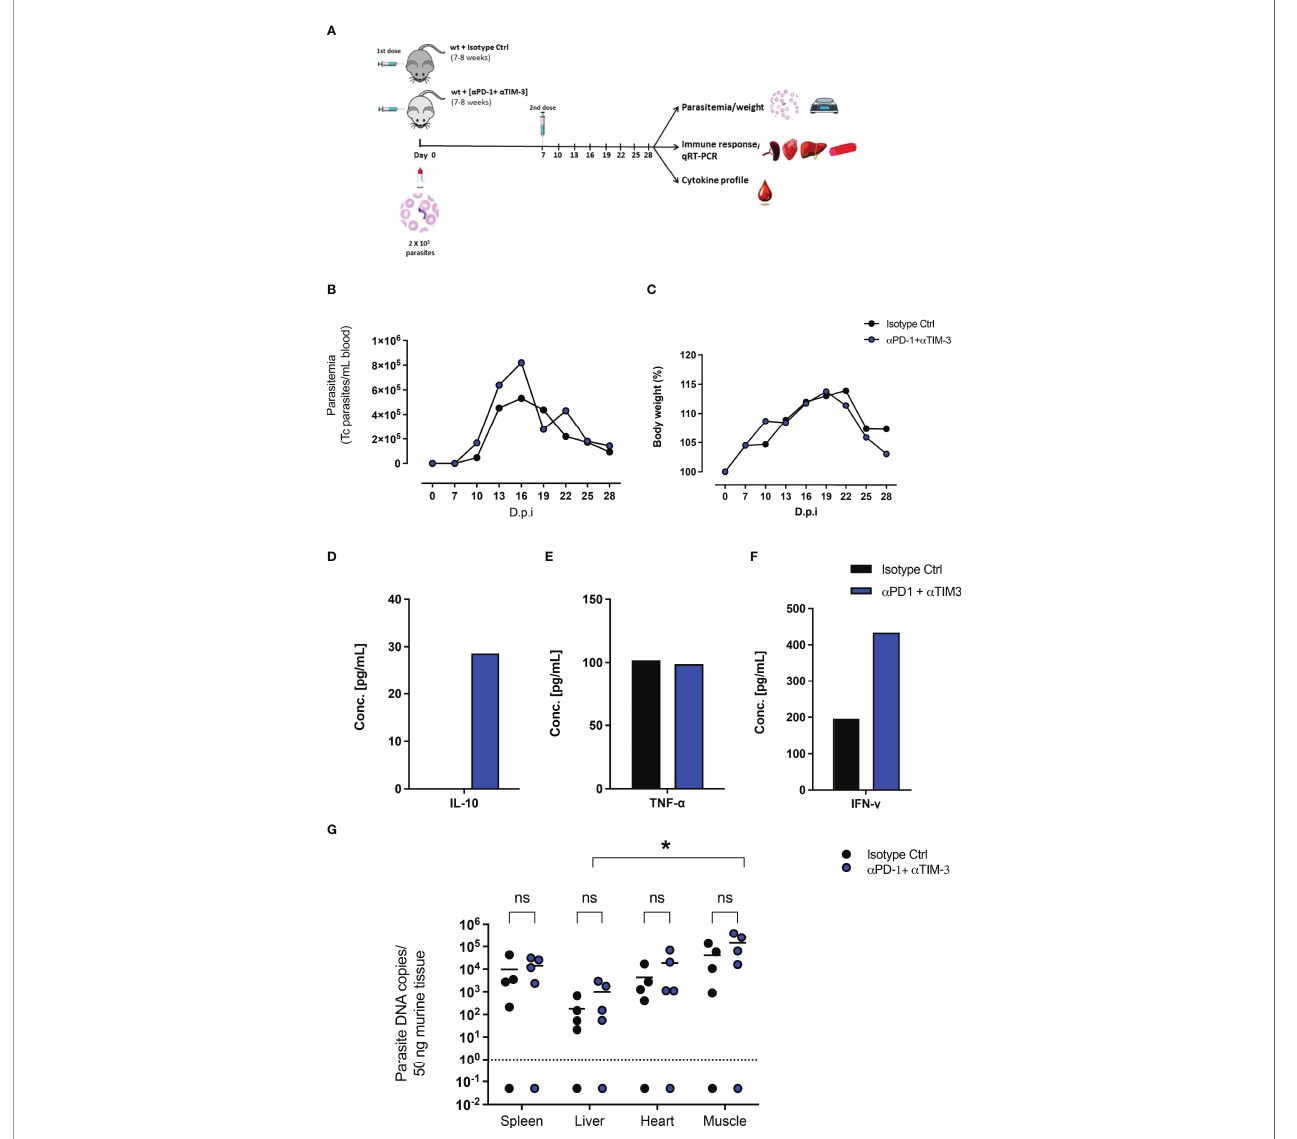
FIGURE 4 | Combined therapeutic intervention with a PD-1 and a Tim-3 monoclonal antibodies does not reduce parasitemia but induces IL-10. (A) Scheme of infection and combined a PD-1 and a Tim-3 therapy. Mice were infected i.p. with 2x10 3 T. cruzi parasites on day 0. They received a PD-1 and a Tim-3 in a concentration of 0.2 mg each/dose on day 0 and day 7 after infection. The control group received i.p. 2 doses of isotype antibody in the same concentration. WT mice infected and isotype treated n=8; WT infected and a PD-1+ a TIM- 3 n=7. Results from two independent experiments (B) Parasitemia and (C) body weight were analyzed over the course of infection (28 days) and are shown as means with SD. Whole blood samples were collected, and sera were isolated and pooled. Cytokine levels were determined by a cytometric bead assay. Results are expressed as the cytokine concentration of the pooled sera samples (D) IL-10, (E) TNF- a , and (F) IFN- g . (G) Effect of interruption of PD-1/PD-L1 signaling on parasite load analyzed by T. cruzi -speci fi c qRT-PCR. Comparative parasite load in spleen, liver, heart, and skeletal muscle from infected and treated with blocking antibodies against a PD-1+ a TIM-3 or their respective isotype controls. Parasite load was calculated from a standard curve. The standard error of the mean is indicated (SEM). Asterisk denotes P values of < 0.05 by One-way ANOVA compared to isotype control values. P < 0.05*; ns (not signi fi